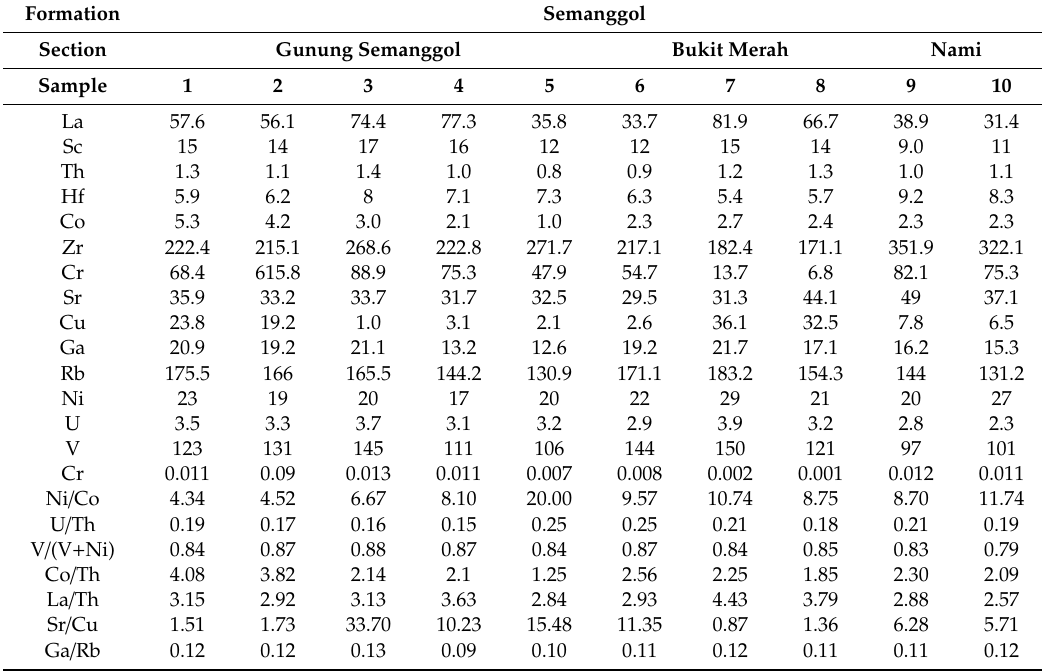
Table 4. Concentrations of selected trace elements (TEs) (ppm) and their ratios of black shale from the Semanggol